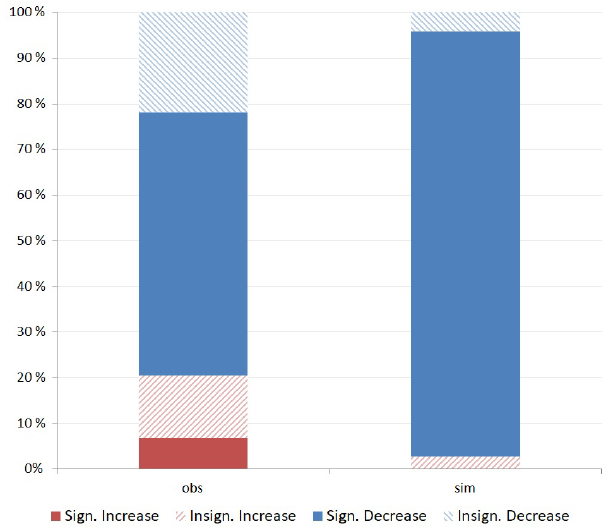
Figure 3. Percentage of sites where statistically significant upward trends (dark red), non-significant upward trends (hatched dark red), significant downward trends (dark blue), and non-significant down- ward trends (hatched dark blue) were obtained for NO 2 observa- tions and simulated